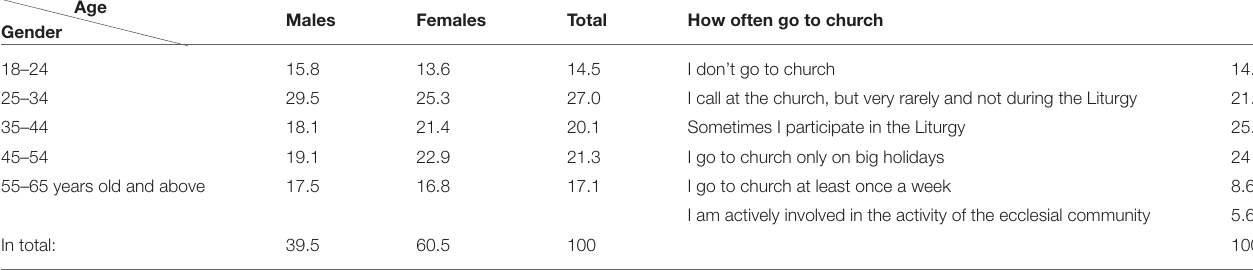
TABLE 2 | Distribution of respondents by age, gender and Church* attendance, participation in Liturgy, and community activities, %. Age Gender